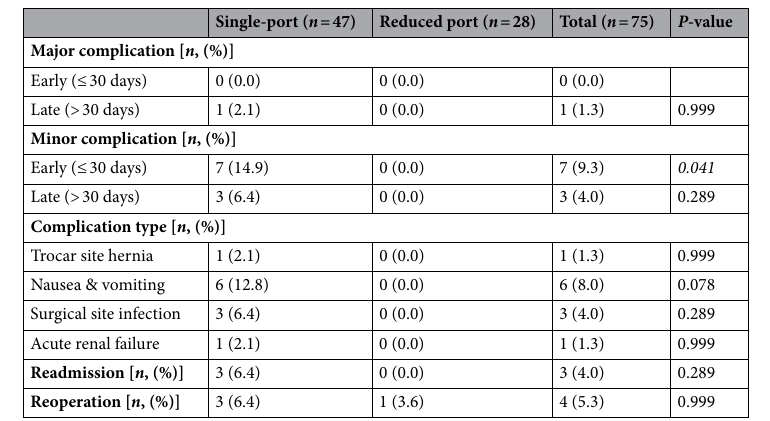
Table 5. Subgroup analysis of single-port and reduced-port laparoscopic sleeve gastrectomy patients for postoperative complications. Significant values are italics. SPSG single-port sleeve gastrectomy, RPSG reduced port sleeve gastrectomy, CLSG conventional laparoscopic sleeve gastrectomy.